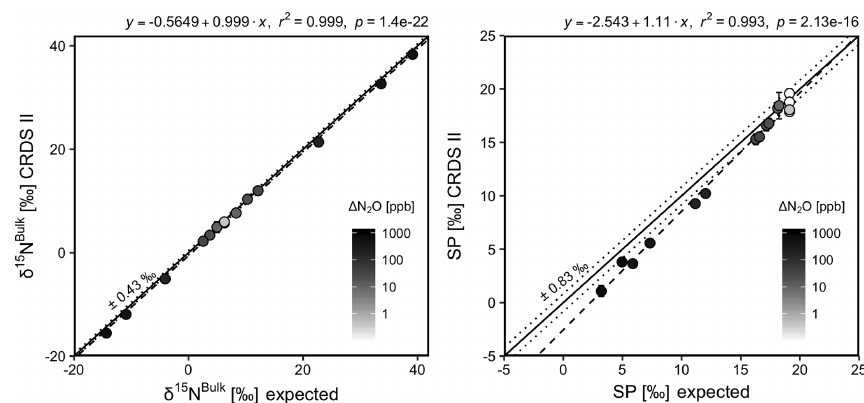
Figure 11. Correlation diagrams for δ 15 N bulk and SP measurements at various (cid:49) N 2 O mole fractions analyzed by CRDS II plotted against expected values. The remaining plots for [ N 2 O ] , δ 15 N α , δ 15 N β and δ 18 O are provided in Sect. S4 (Fig. S4-12). The solid black line denotes the 1 : 1 line, while the dotted line indicates ± 1 σ of the residuals from the 1 : 1 line. The dashed black line represents a linear fit to the data. Individual equations, coefficients of determination ( r 2 ) and p values are indicated above each plot. Each data point represents the mean and standard deviation (1 σ ) of triplicate measurements. The inset plots indicate the standard deviation (1 σ ) of the triplicate measurements achieved at different (cid:49) N 2 O mole fractions, and the 1 : 1 line is similarly a solid line.